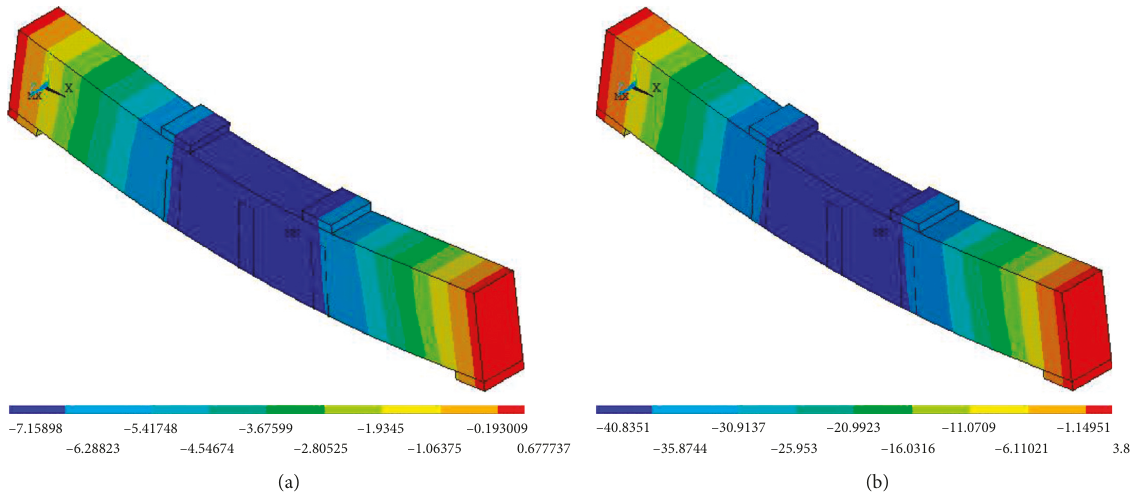
Figure 11: 3D views of deflections in the B3 model at (a) the yield load stage and (b) the maximum load